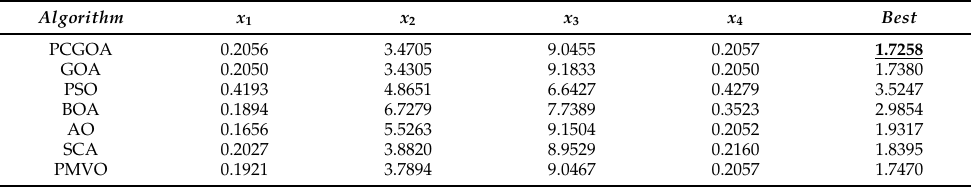
Table 6. Comparison results of each algorithm for the welded beam design problem.